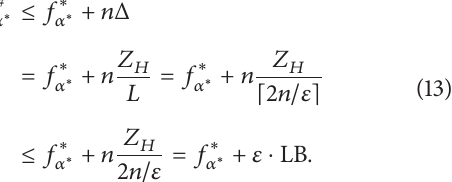
Algorithm MPR schedules jobs from the end of